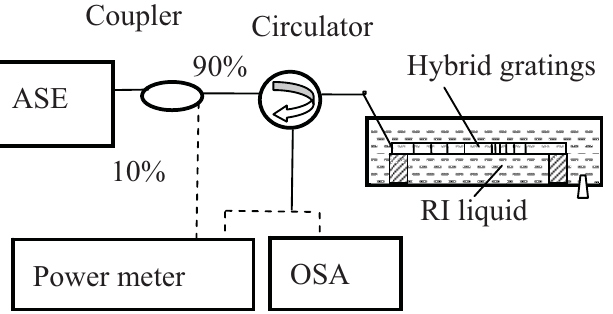
Figure 3. Experimental setup of hybrid LPG/CFBG for RI